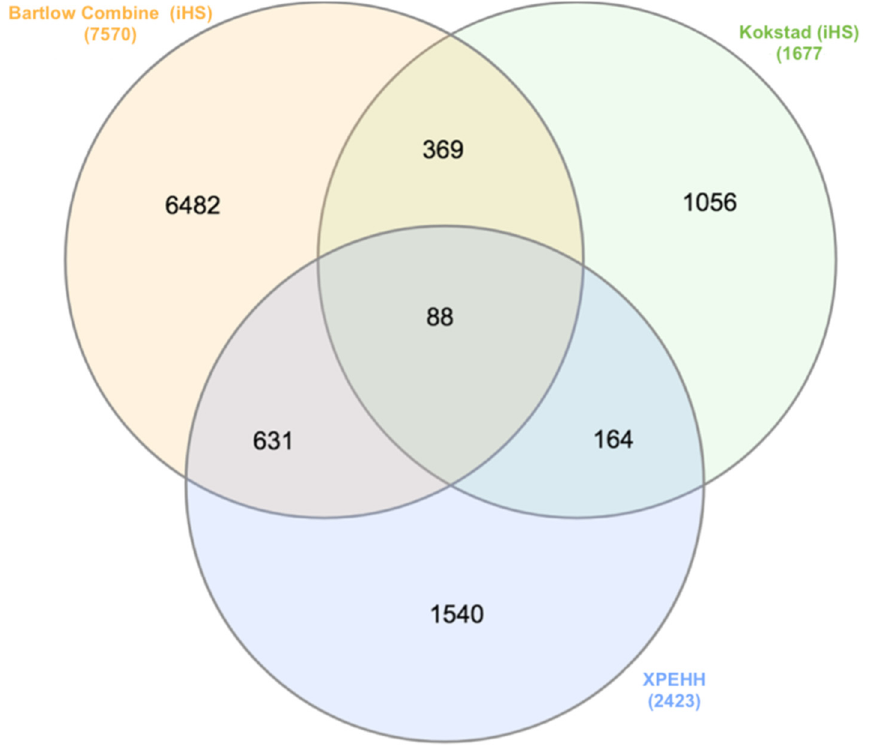
Figure 10. Venn diagram comparing the unique and shared genes under selection between the Bartlow Combine and Kokstad